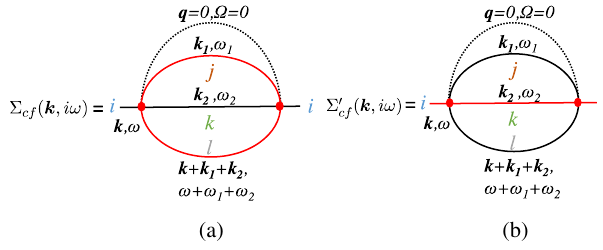
FIG. 4. The self-energy diagrams in the two-band model due to interband scattering for (a) c fermions Σ with orbital index i . The solid black (red) lines represent fully dressed Green ’ s functions, G and (28b). The dashed lines correspond to U 2 carry no frequency or